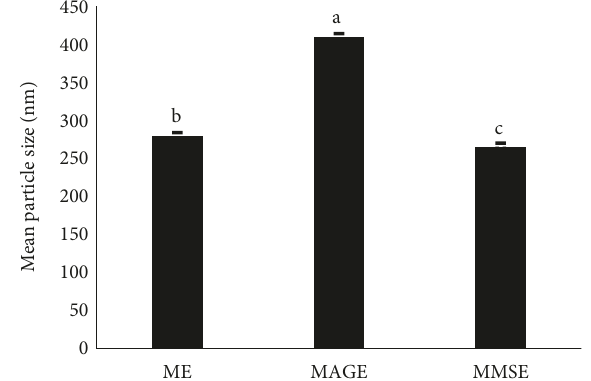
Figure 3: Mean particle size of MP microcapsules with different carrier materials: maltodextrin/extract (ME), maltodextrin/Arabic gum/extract (MAGE), maltodextrin/modified starch/extract (MMSE). different lowercase letters show statistically significant differences ( p < 0 . 05).